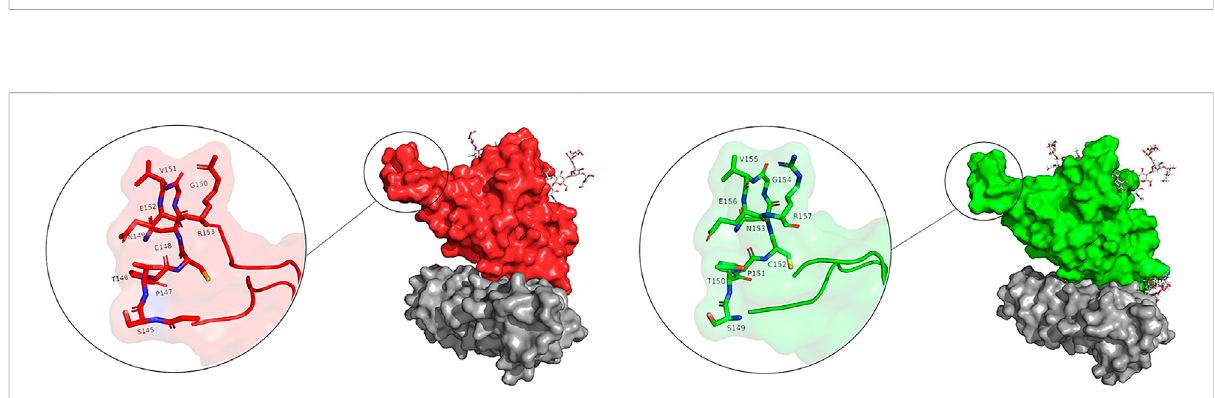
FIGURE 4 RMSF of all systems is calculated over 100 ns MD simulations. Fluctuations of CA atoms calculated for all replicates of RBDfN, gRBDfN, and gmRBDfNsystemsareshowninblack,red,andgreen,respectively.ThedashedlineshowstheboundarybetweentheRBDandferritinaminoacids.In the upper panel, reference amino acid sequences are the amino acids of the RBD